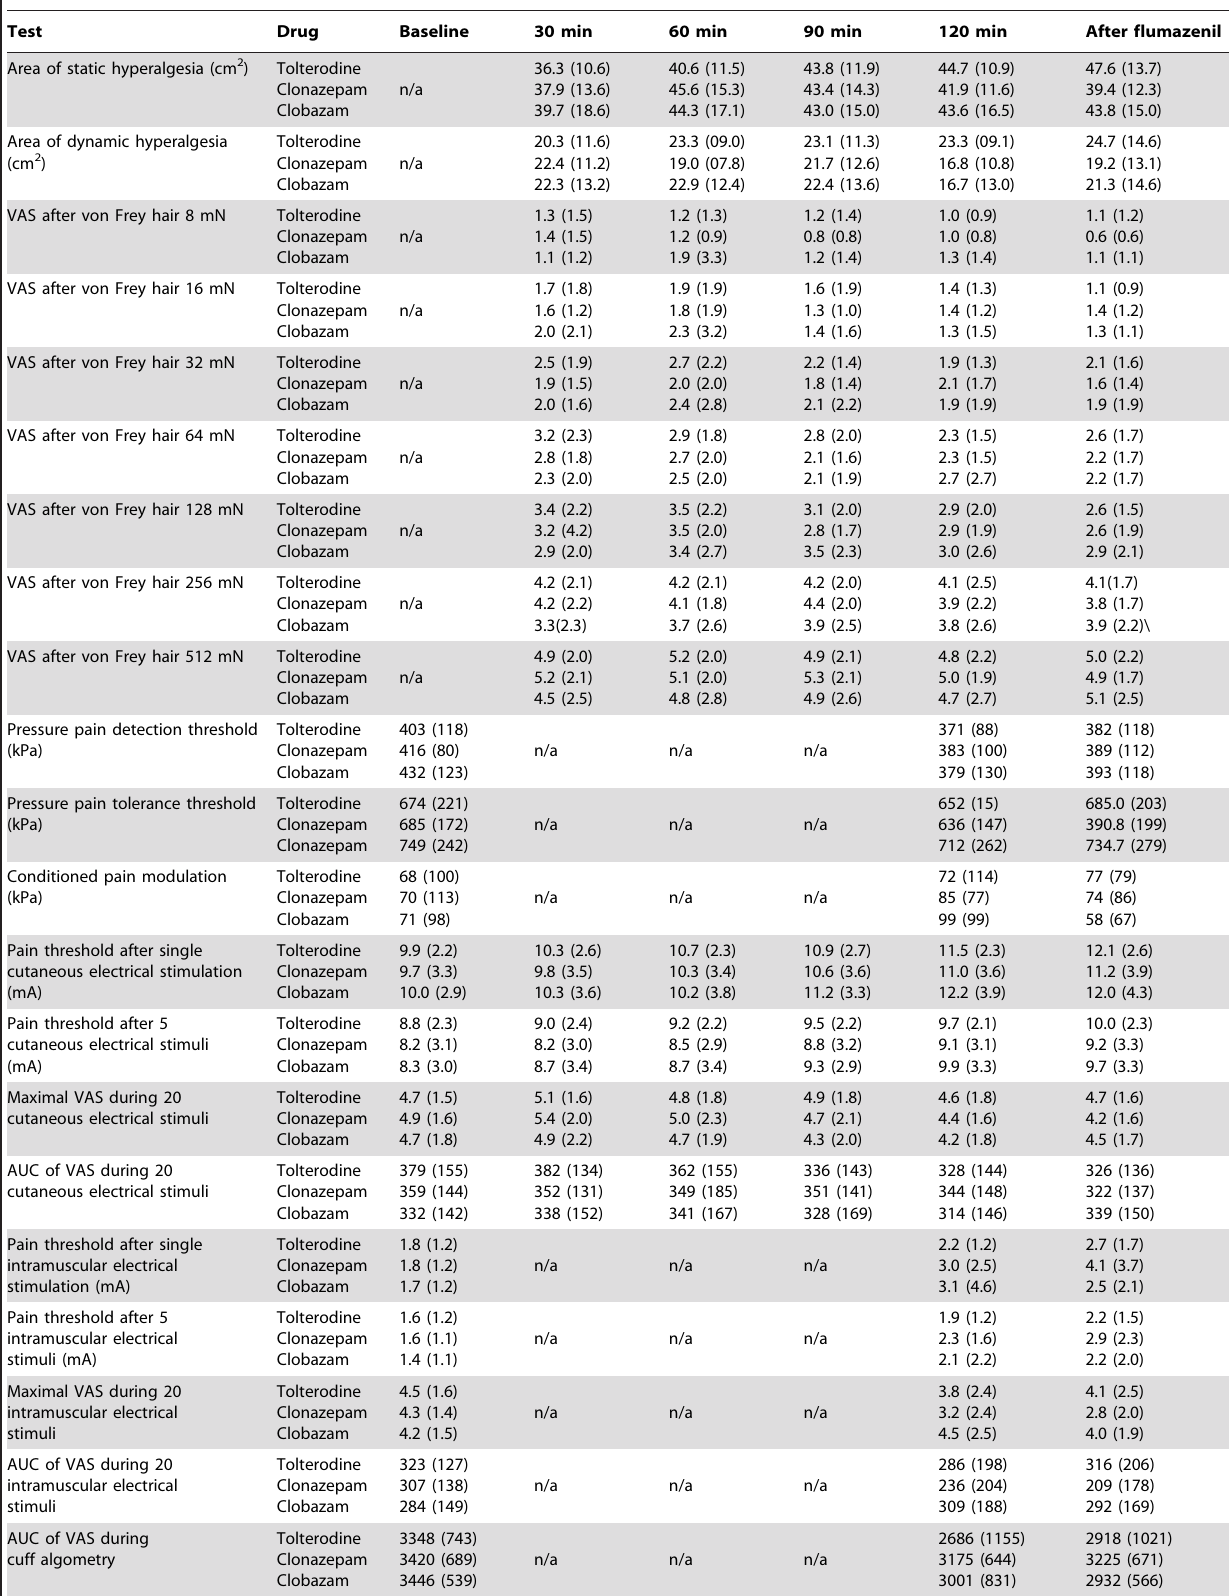
Table 2. Results of the pain tests